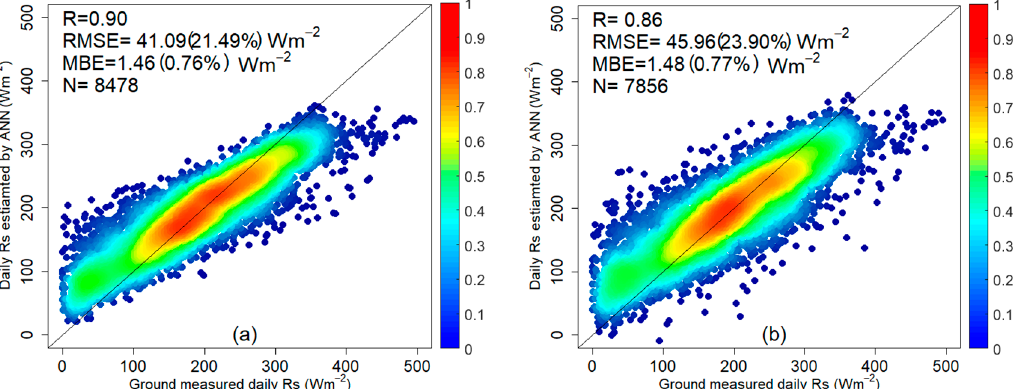
Figure 13. Evaluation results of daily estimated R S data from Himawari-8 AHI data using the ANN method with ground-measured R S from CDC / CMA from February to May 2016: ( a ) for training data; ( b ) for validation data. N is the number of data point.